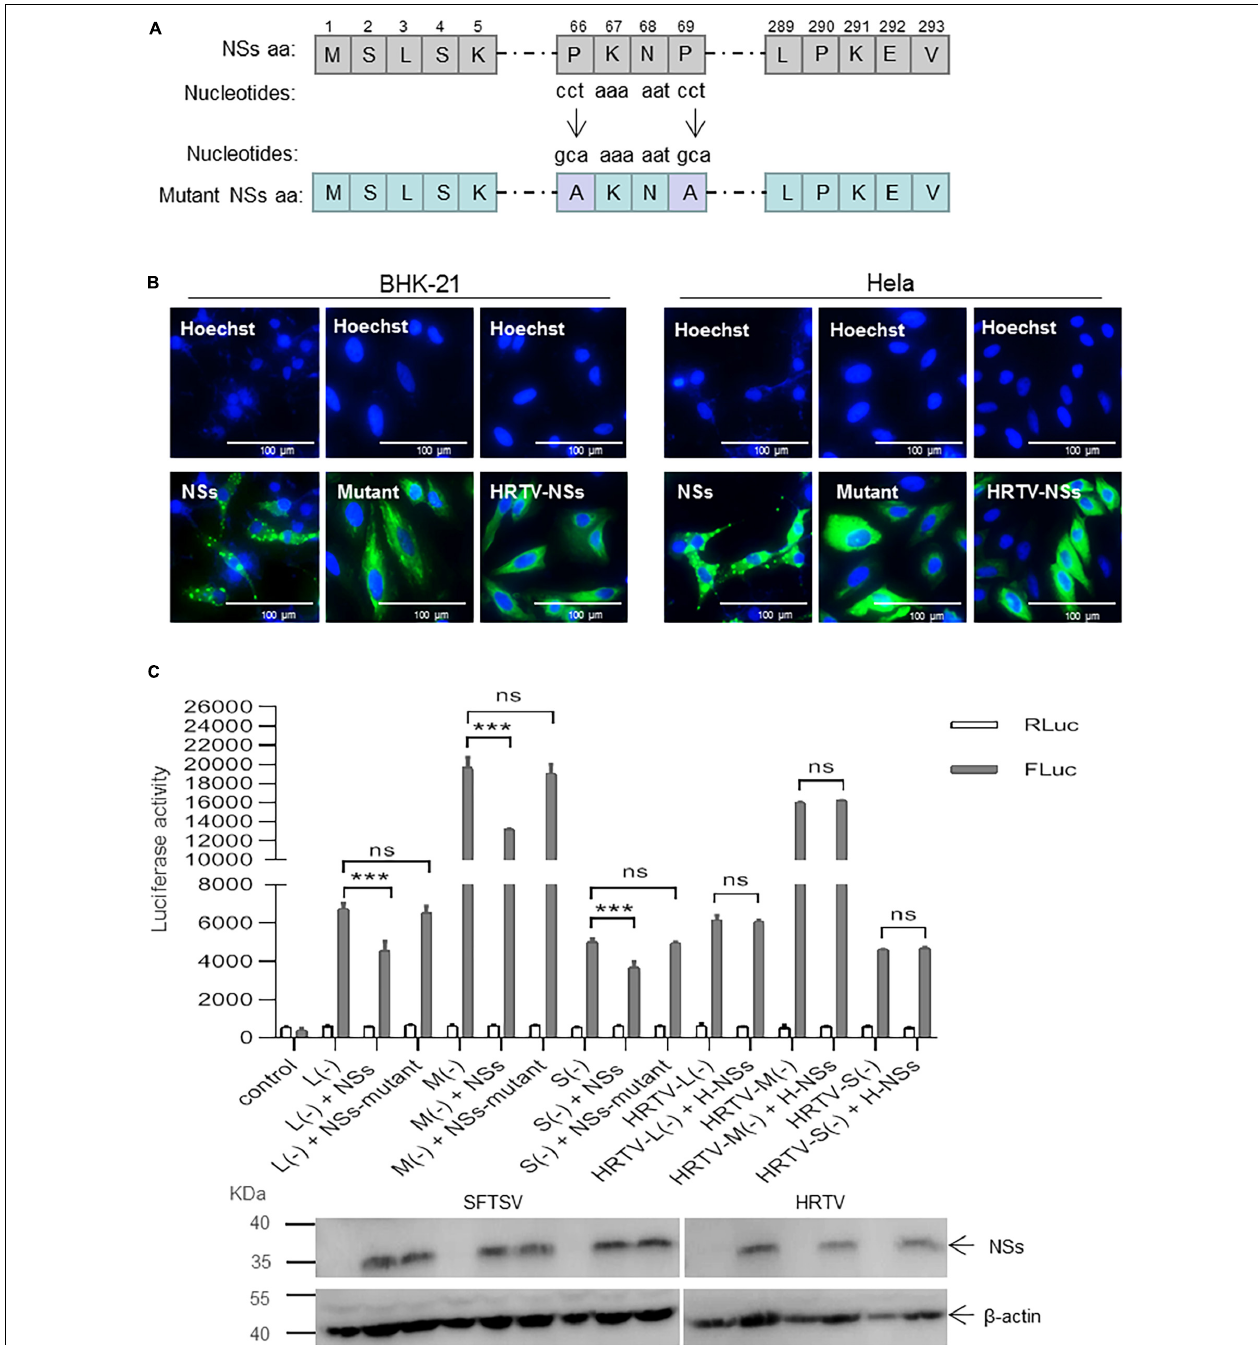
FIGURE 6 | Formation of NSs-induced IB structure is important for the suppression of virus-like RNA synthesis. (A) Schematic of mutant NSs clone. The amino acids at positions 66 and 69 were substituted by alanine via the introduction of mutant nucleotides to NSs encoding gene (“cct” were mutated to “gca”). Mutant clone (pCAG-SV-NSs-mutant) was constructed by double restriction enzyme digest ( Kpn I and Not I) and In-Fusion technology (Clontech, Japan). (B) When BHK-21 and Hela cells were respectively, transfected with pCAG-SV-NSs, pCAG-SV-NSs-mutant, or pCAG-HRTV-NSs, IFA was performed 48 hpt to observe wild-type, mutated SFTV NSs and HRTV NSs under immunofluorescence microscopy. (C) Minigenome reporter assays were performed as previously described. BHK-21 cells in a 12-well plate were transfected with 1.0 µ g of pRF42-SV/HRTV-L/M/SUTR-FLuc (–), 0.5 µ g of pCAG-SV-RdRp, and 0.5 µ g of pCAG-SV-N together with 0.5 µ g of SFTSV NSs/mutant NSs-expression plasmid DNA or HRTV NSs-expression plasmid DNA and 10 ng of internal control plasmid pRL-TK. Meanwhile, a control group with pRF42-FLuc replacing pRF42-SV/HRTV-L/M/SUTR-FLuc was also set up. The activities of firefly and Renilla luciferase were measured at 48 hpt, respectively. Data are presented as the mean ± SEM ( n = 3). *** p < 0.001; ns, non-significant. The expression levels of SFTSV NSs/mutant NSs and HRTV NSs were analyzed, respectively, by Western blot.